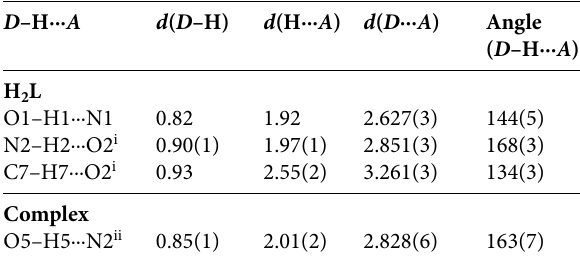
Table 3 Hydrogen bond distances (Å) and bond angles (°) for H 2 L and the complex D –H∙∙∙ A